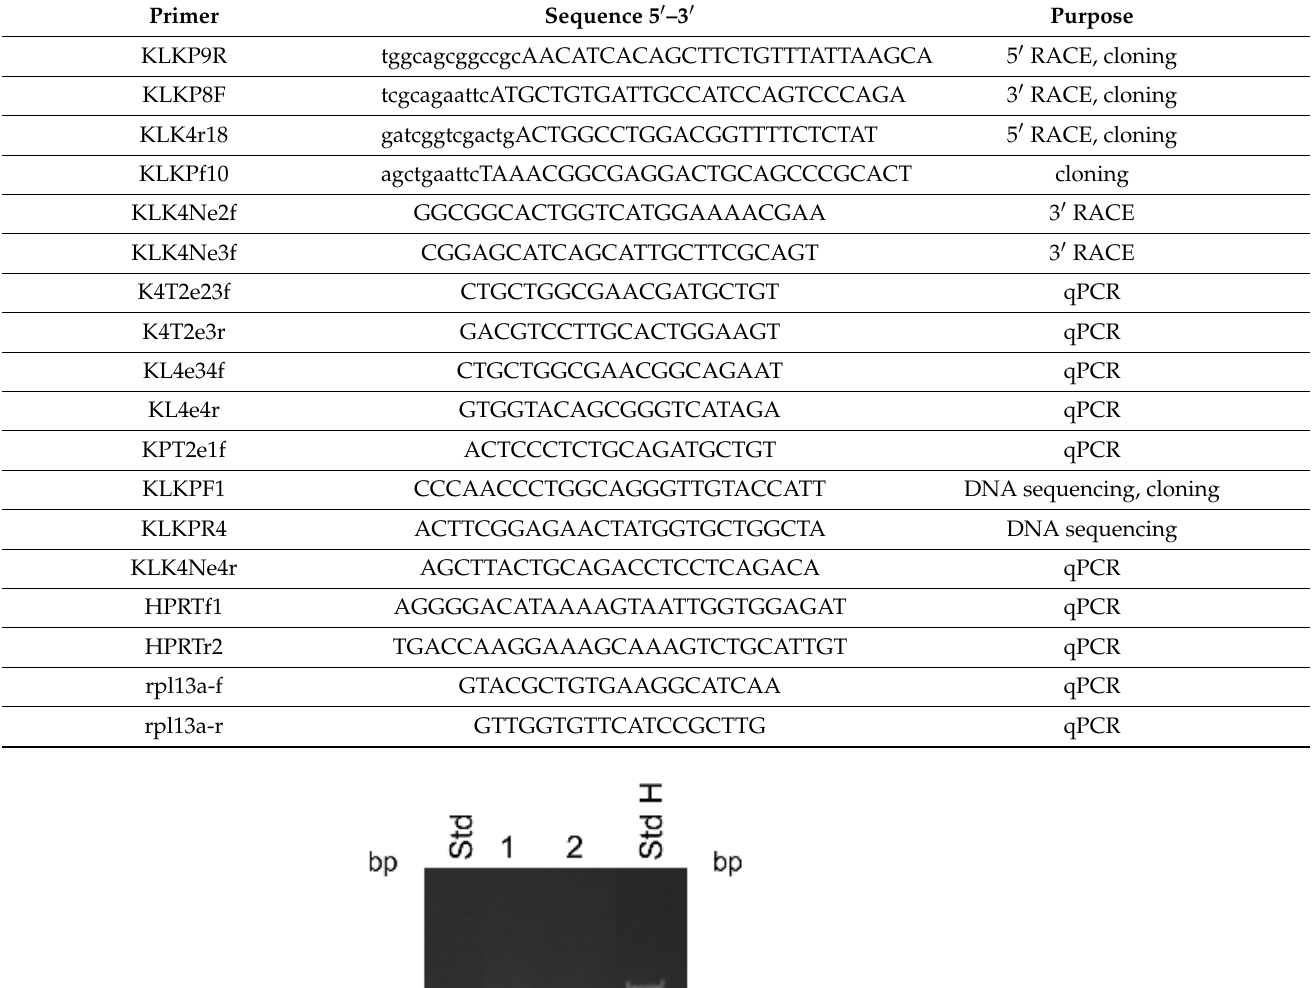
Table 1. Primers used for PCR, cloning, and DNA sequencing. Bases written in lower case are non-sequence-specific nucleotides included for the cloning procedure.